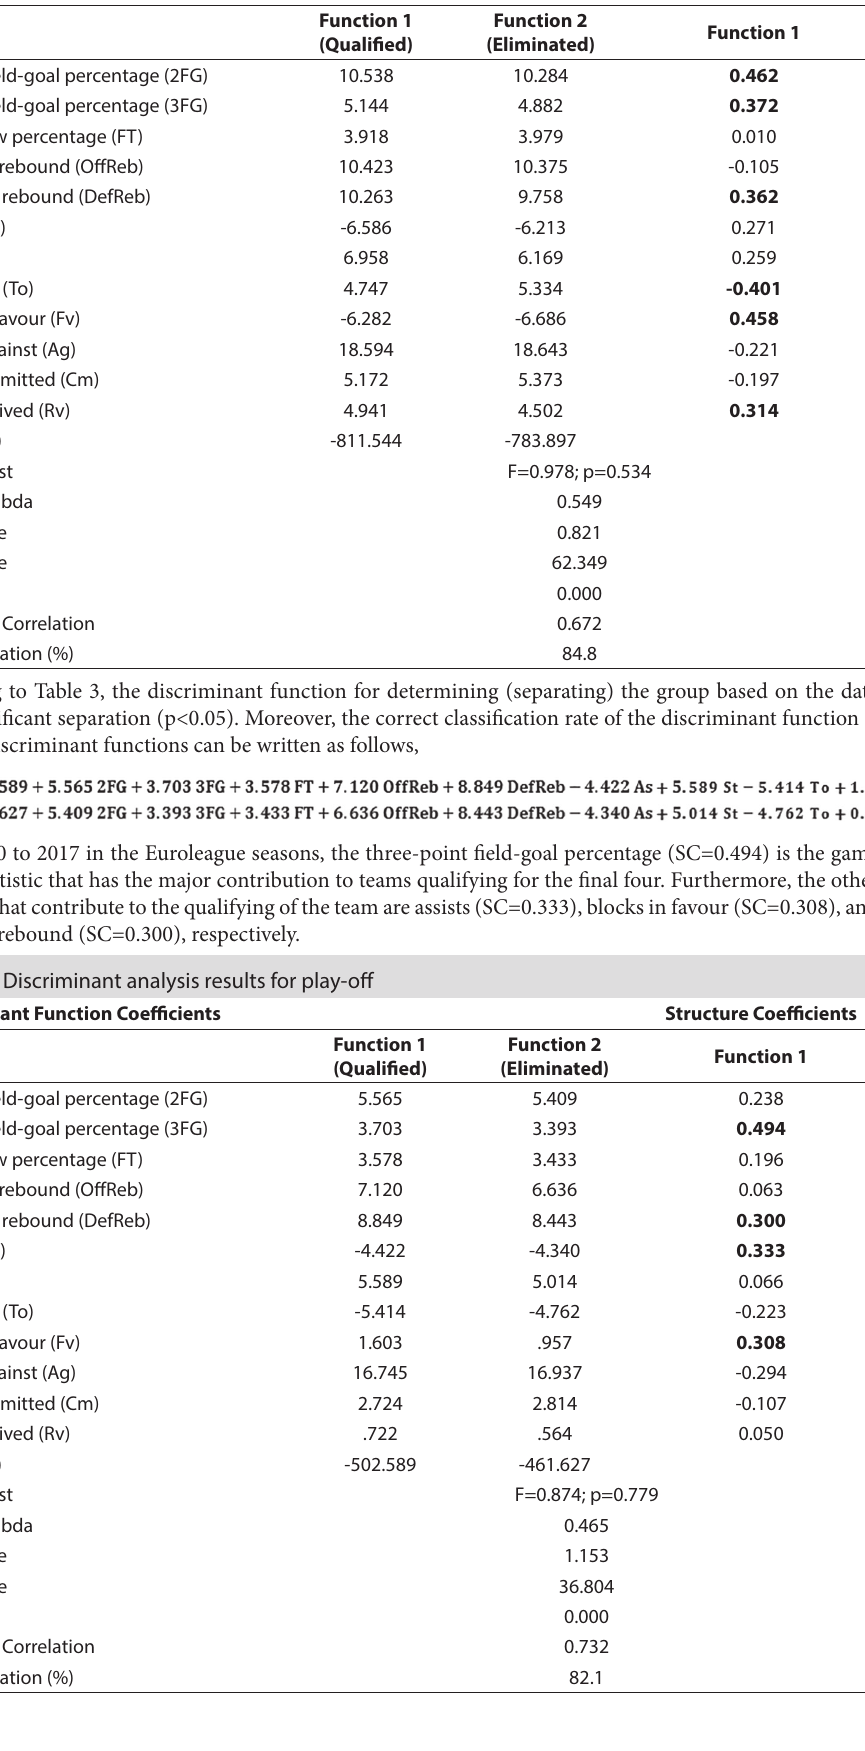
TABLE 2 Discriminant analysis results for the top sixteen